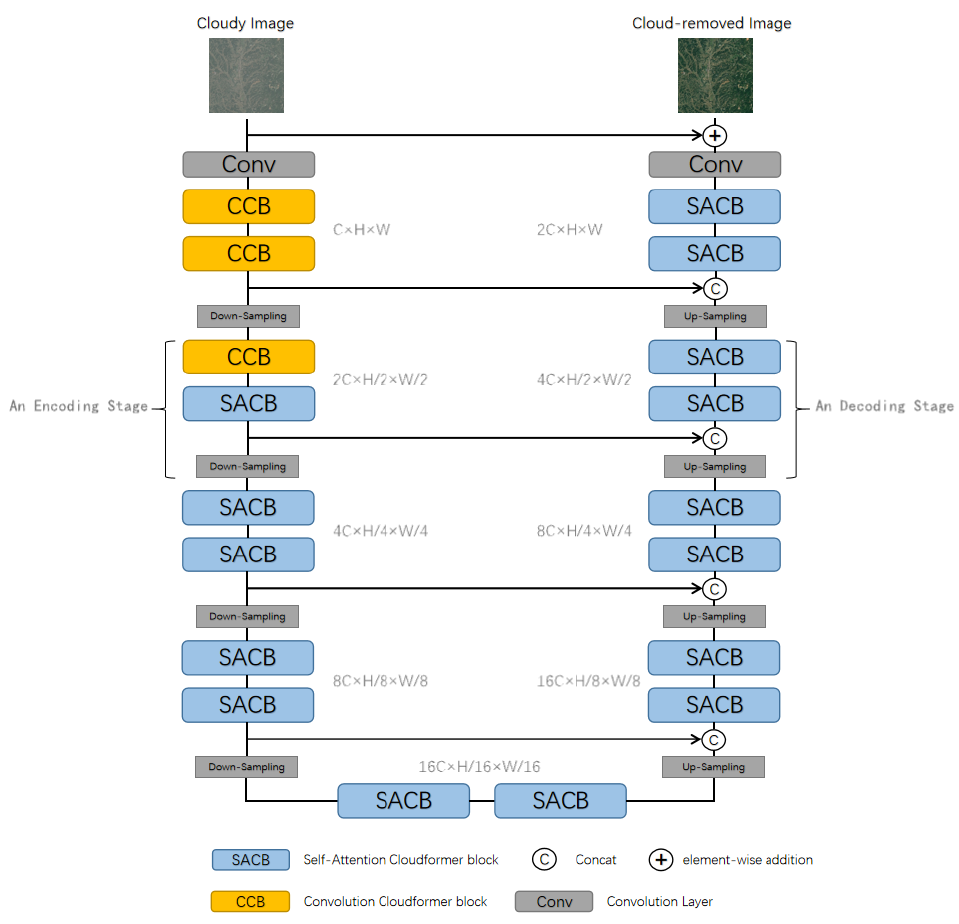
Figure 1. Overall architecture of